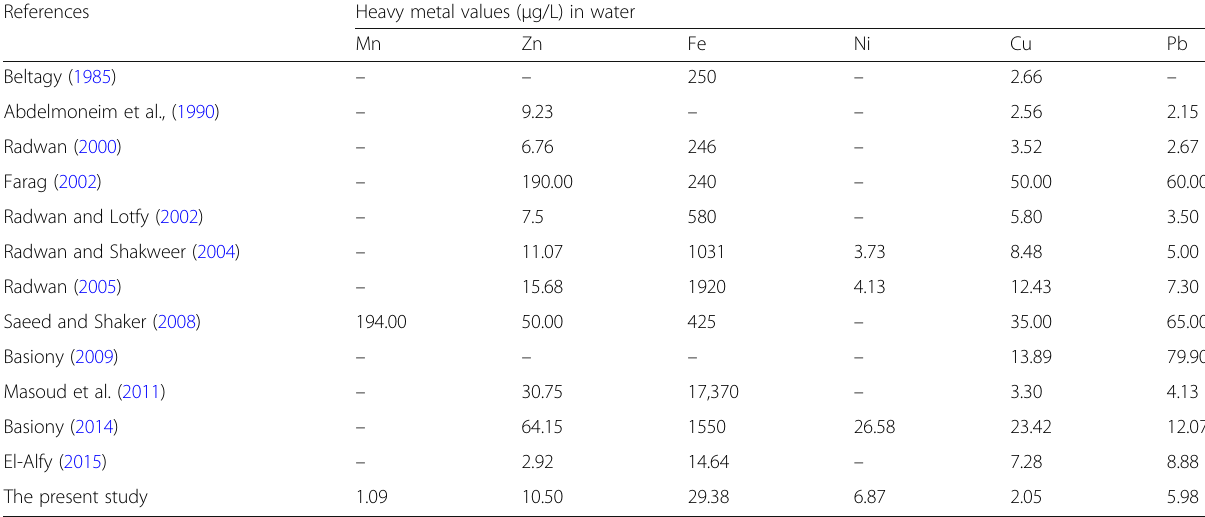
Table 12 Comparison between heavy metal concentrations of ( μ g/L) in Burullus Lake water of the present study with the previous studies